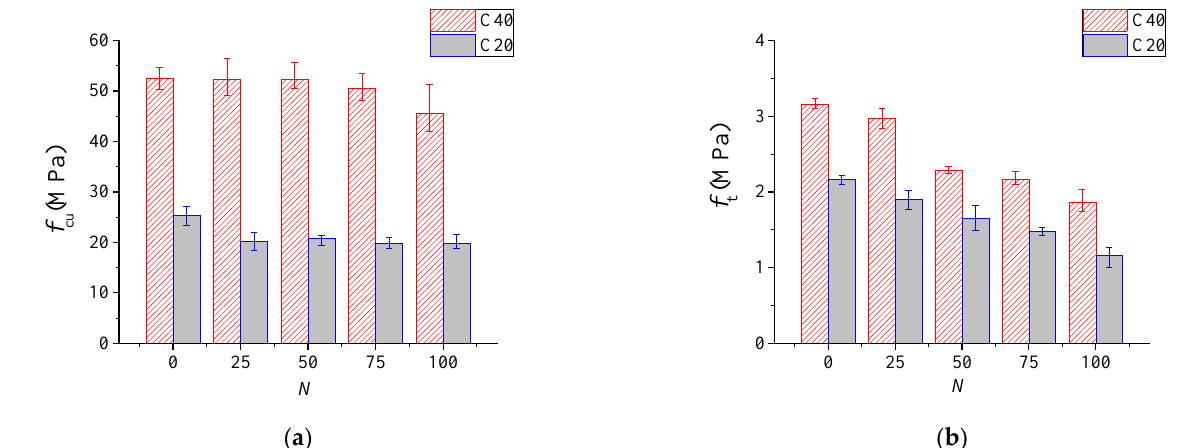
Figure 6. Concrete strengthunder different freeze–thaw cycles N . ( a ) Compressive strength; ( b ) splitting tensile strength.